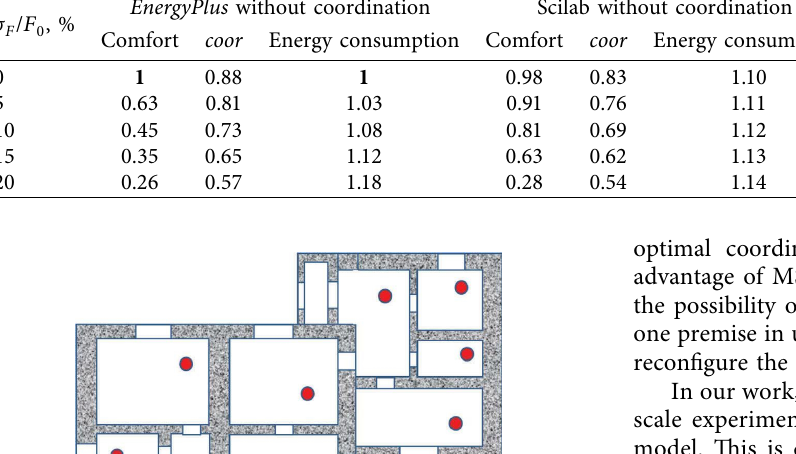
Table 3: Te results of comparing the efciency of the system with and without coordination. EnergyPlus without coordination σ F / F , % 0